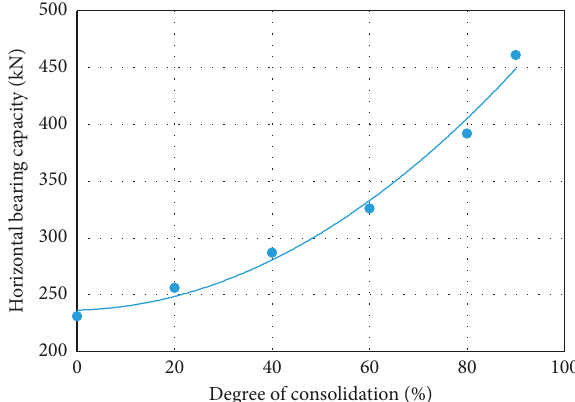
Figure 11: Relationship between horizontal bearing capacity and degree of consolidation.